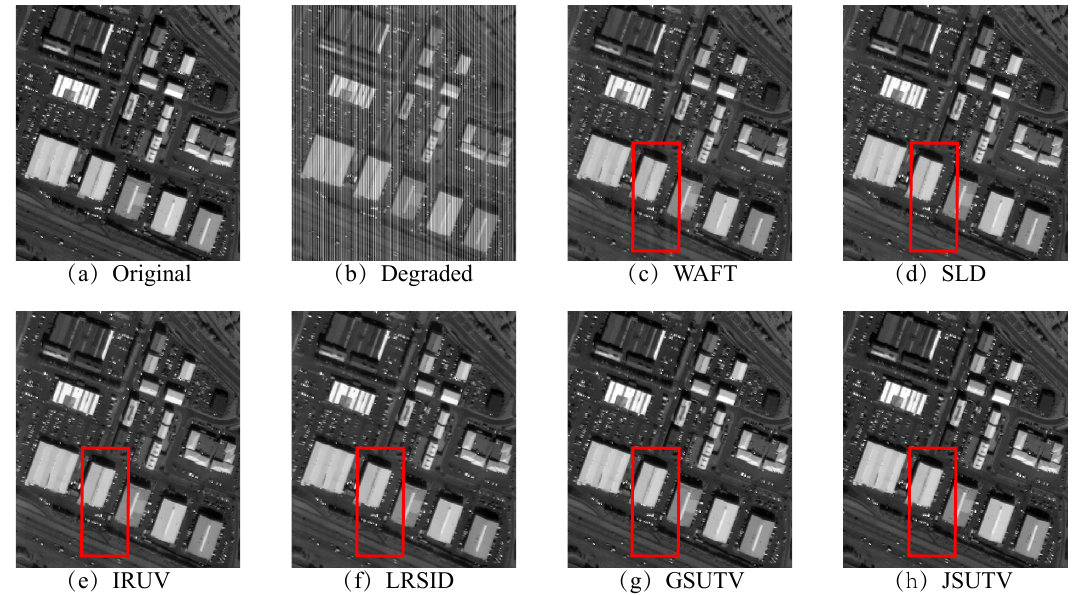
Figure 5. Simulated destriping results of Case 3. ( a ) Original image; ( b ) degraded image; destriping images of: ( c ) WAFT; ( d ) SLD; ( e ) IRUV; ( f ) LRSID; ( g ) GSUTV; ( h )